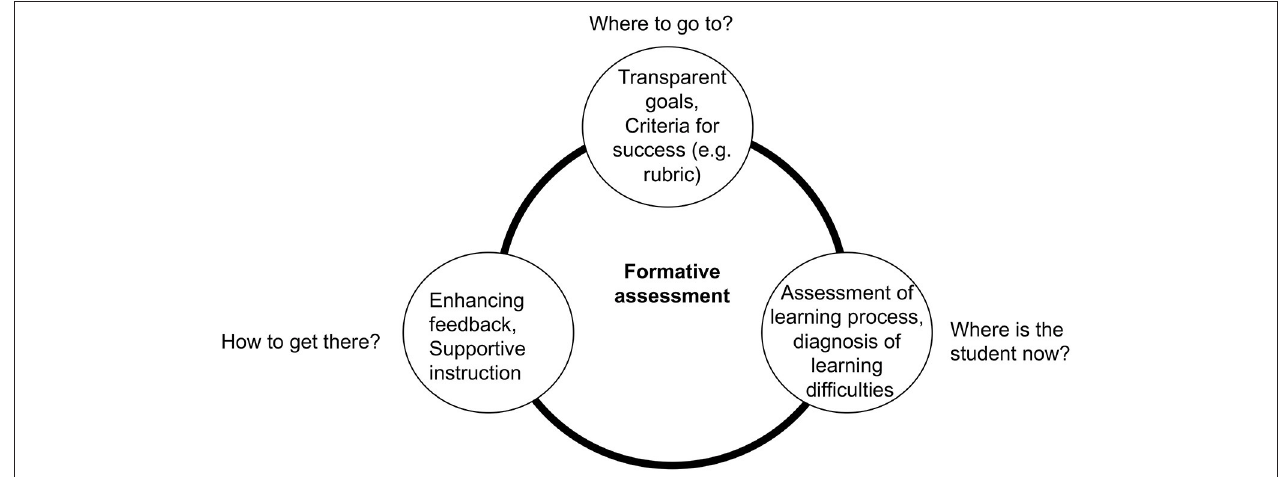
FIGURE 1 | Relationship of a rubric, assessment/diagnosis, and feedback as components of formative assessment (adapted from Black and Wiliam, 2009).